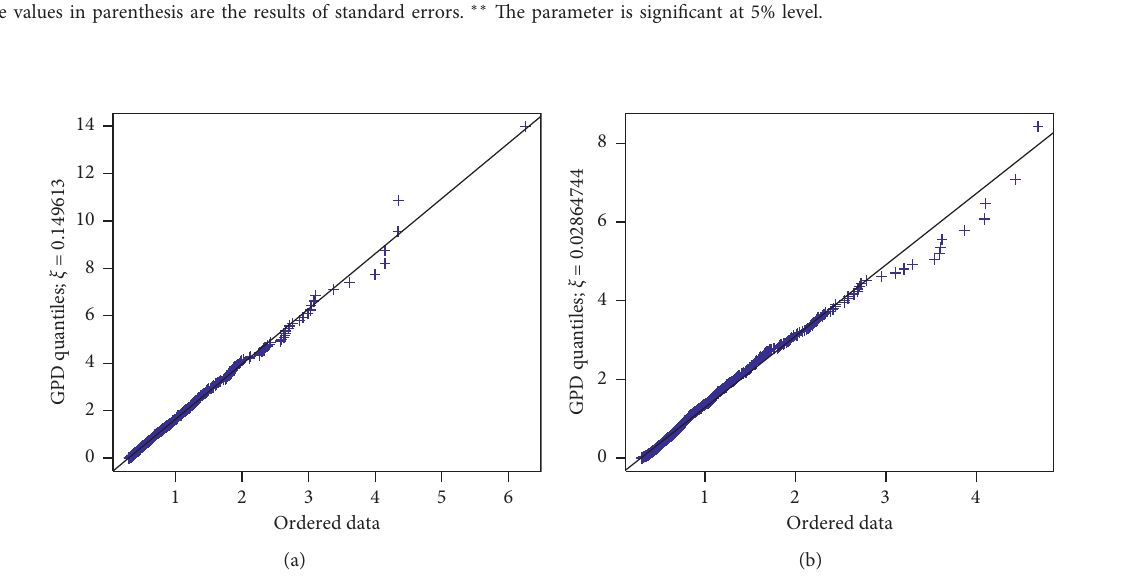
Figure 2: QQ-plots of generalized Pareto distribution fitting for the (a) SH composite index and (b) SZ component